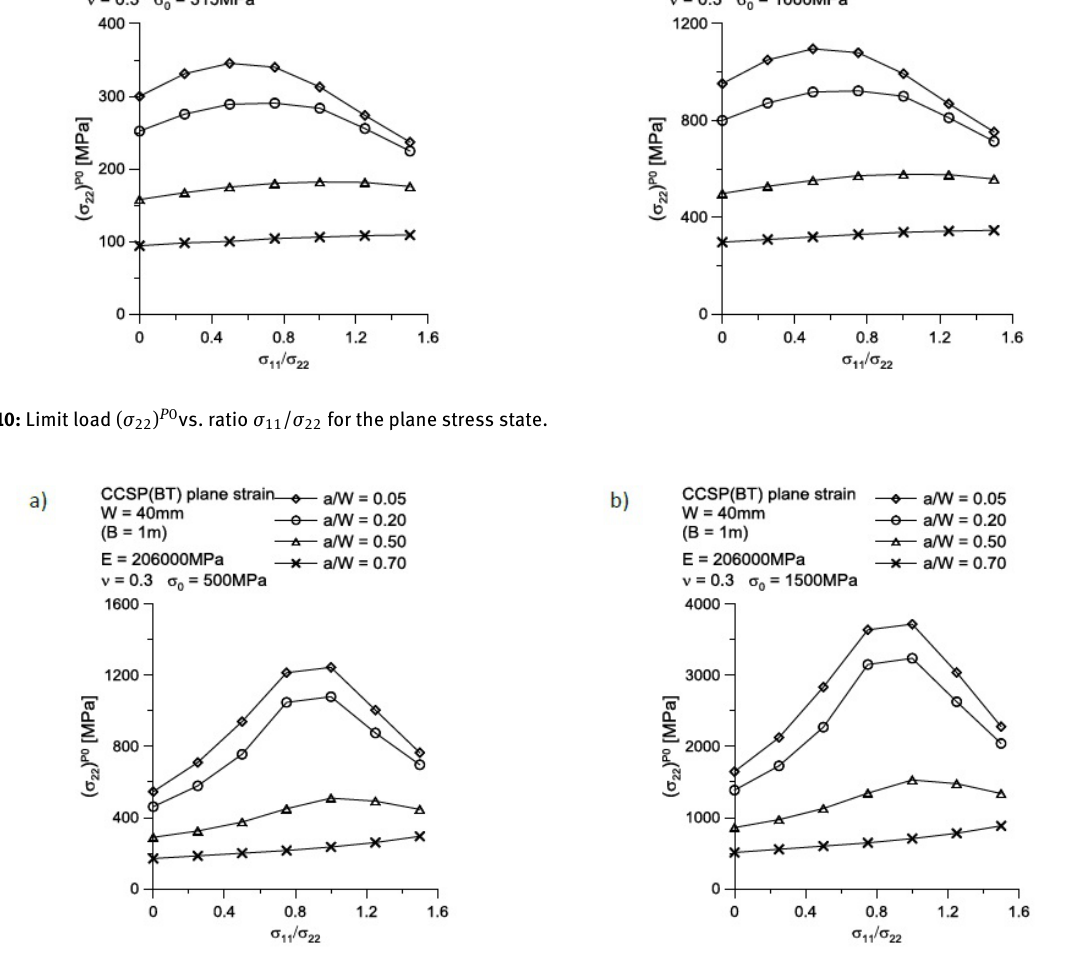
Figure 11: Limit load ( σ 22 ) P 0 vs. ratio σ 11 / σ 22 for the plane strain